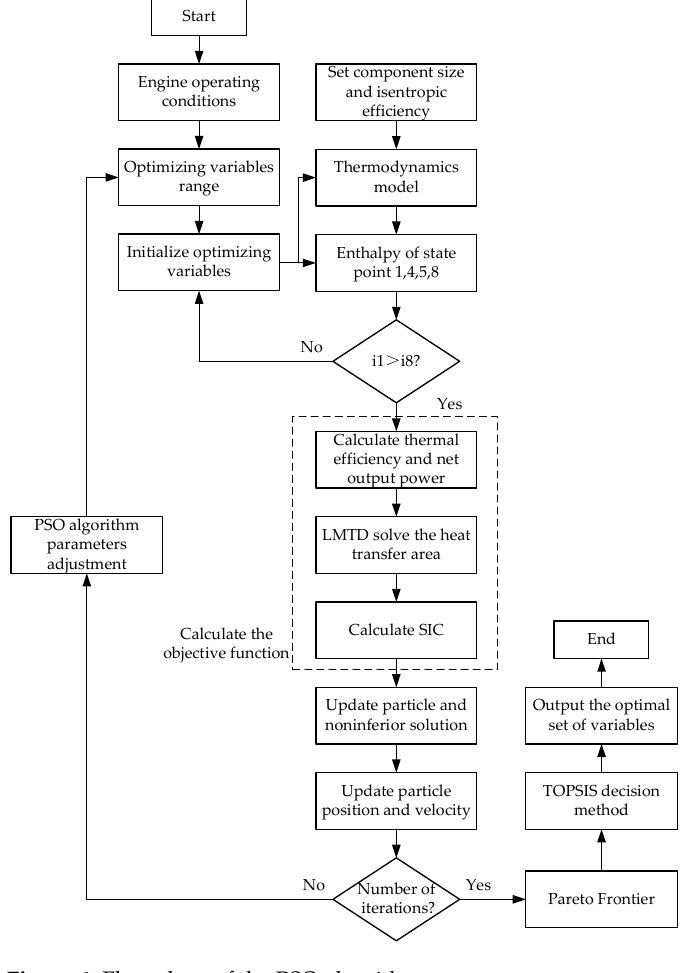
Figure 6. Flow chart of the PSO algorithm. The particle swarm algorithm simulates a bird in a flock by designing a massless particle with only two properties: velocity and position, where velocity represents the speed of movement and position represents the direction of movement. Each particle Table 2. The value ranges of the optimization variables